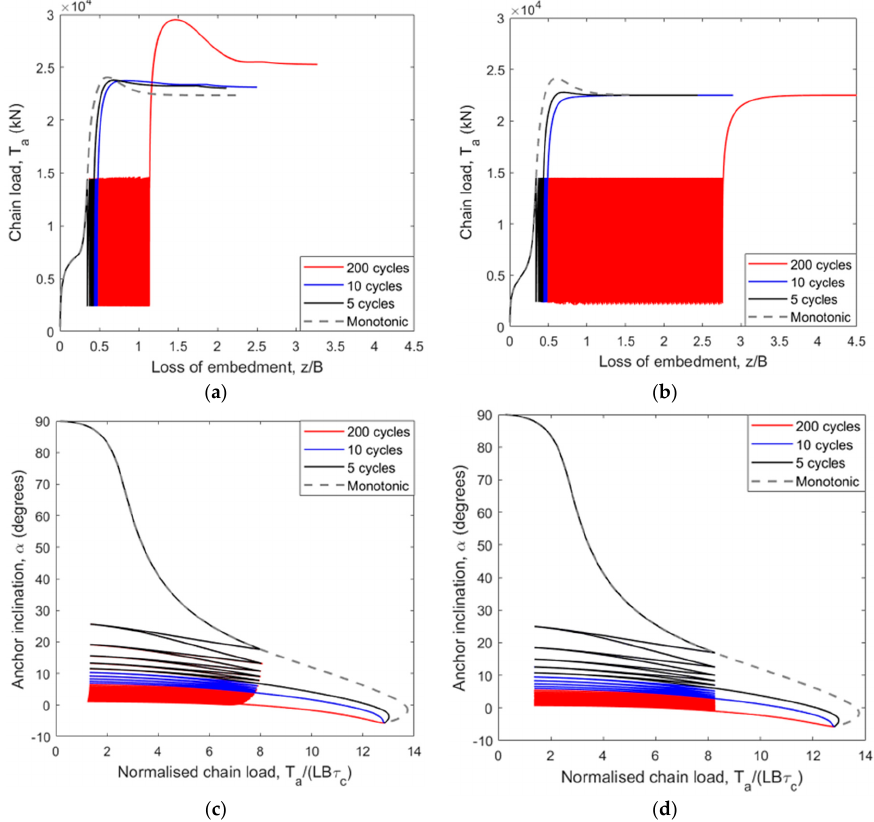
Figure 13. Effect of the number of cycles on anchor capacity ( a ) with and ( b ) without consolidation and on anchor rotation ( c ) with and ( d ) without consolidation.